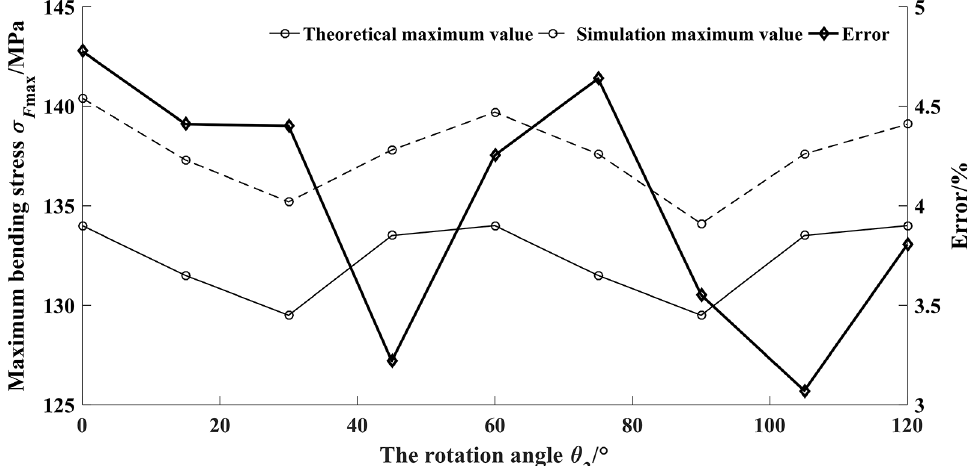
Fig. 16. Theoretical maximum value and simulation maximum value.